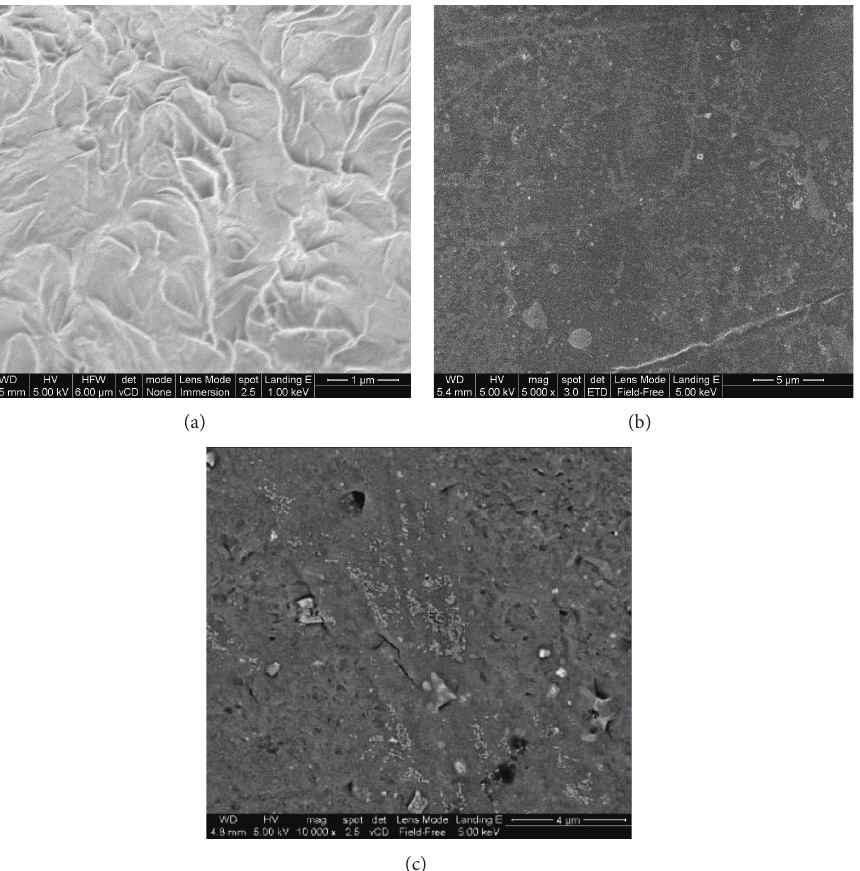
Figure 1: SEM of (a) Pure HPDE, (b) HDPE-C15A, and (c)